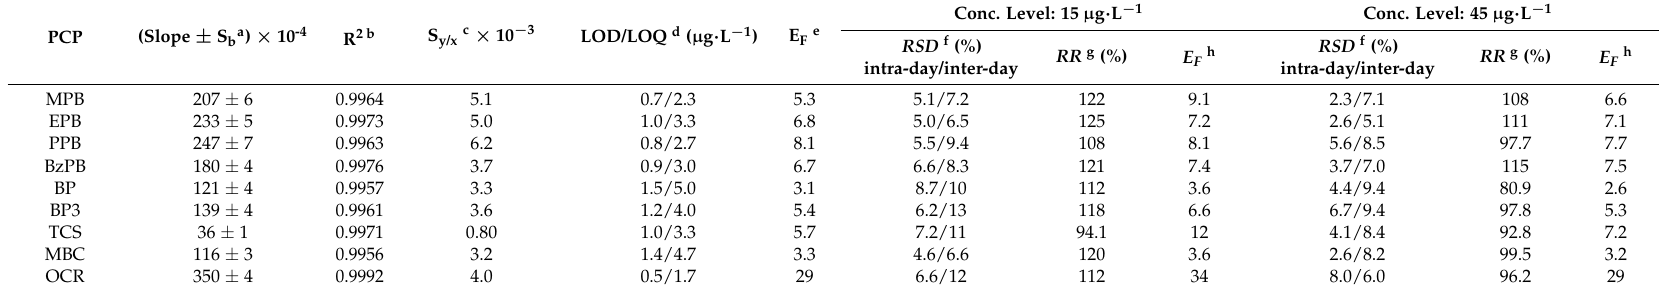
Table 1. Several quality analytical parameters of the optimized D- µ SPE-UHPLC-UV